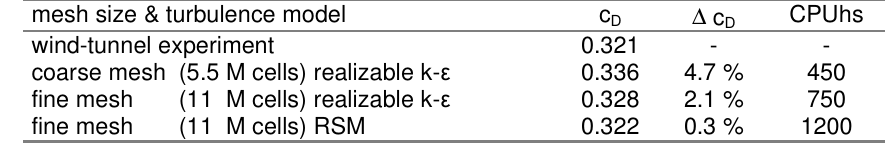
Table 1: Comparison of results for different modeling approaches [1] The results clearly show the improvement of simulation accuracy in comparison to windtunnel results, when more effort is put into the modeling approach. In the next sections the most common modeling approaches for Geometry Cleanup, Meshing and Simulation are